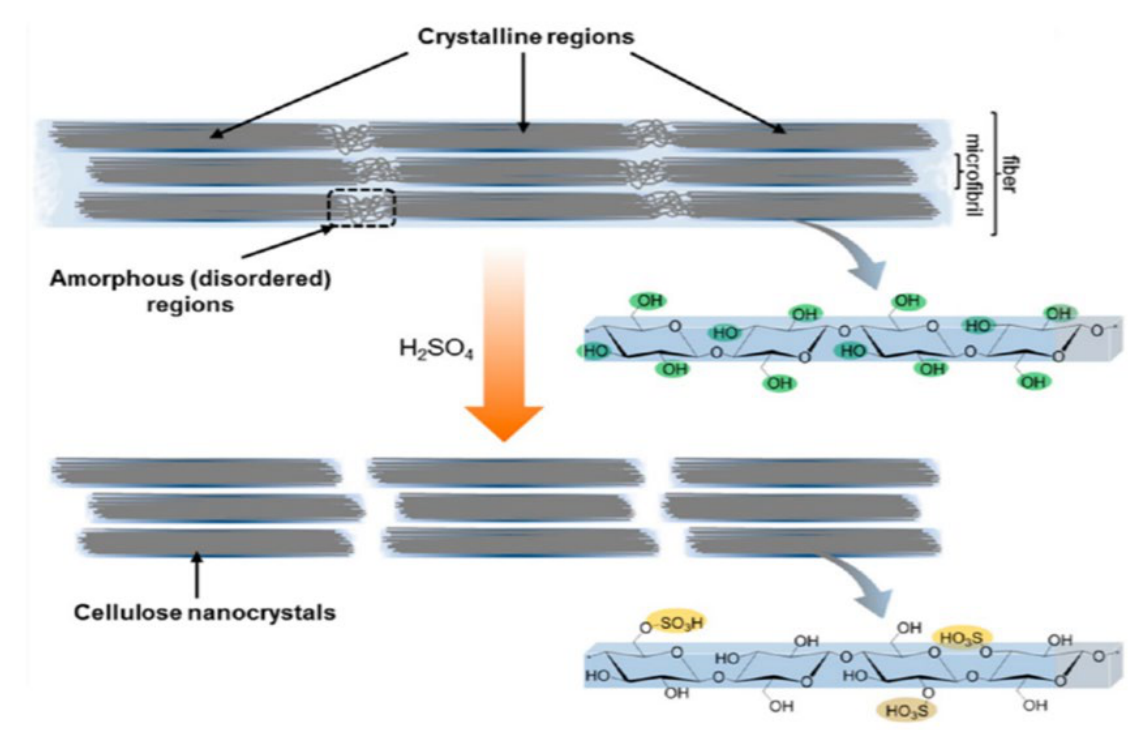
Figure 4. Schematic representation of crystalline region and amorphous region in cellulose and the formation of cellulose nanocrystals. Reprinted with permission from Ref. [78]. Copyright 2014 American Chemical